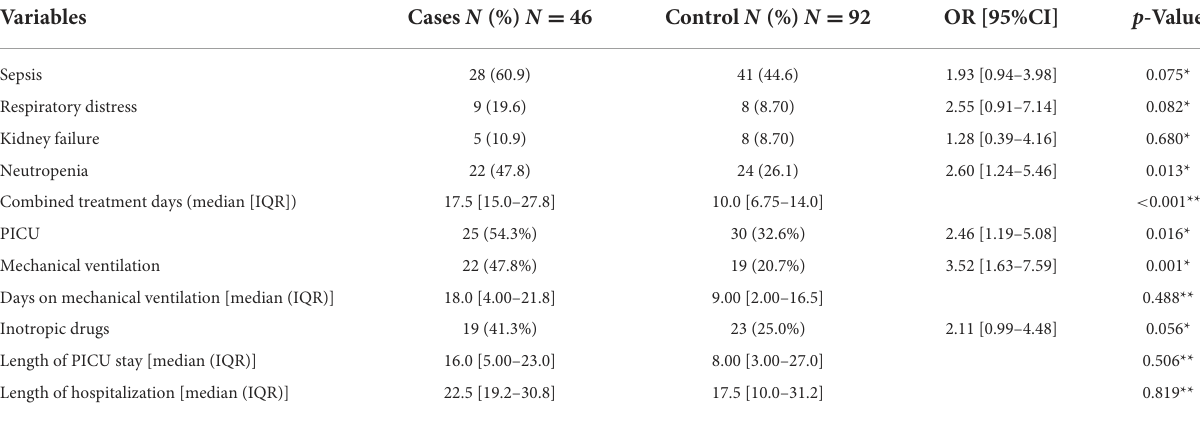
TABLE 2 Main outcomes and use of resources in cases and